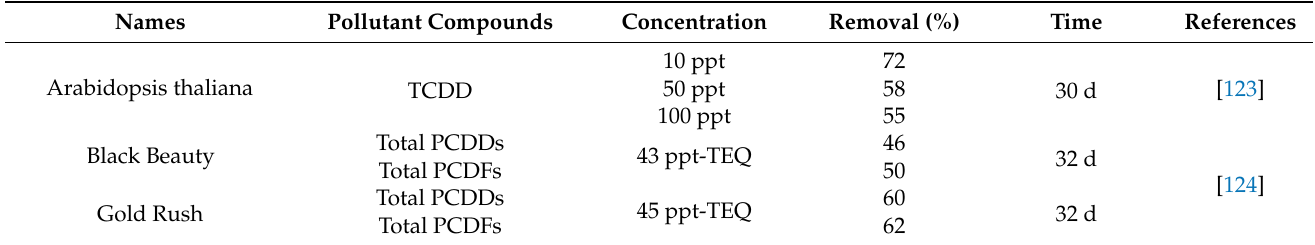
Table 7. Degradation of dioxins by